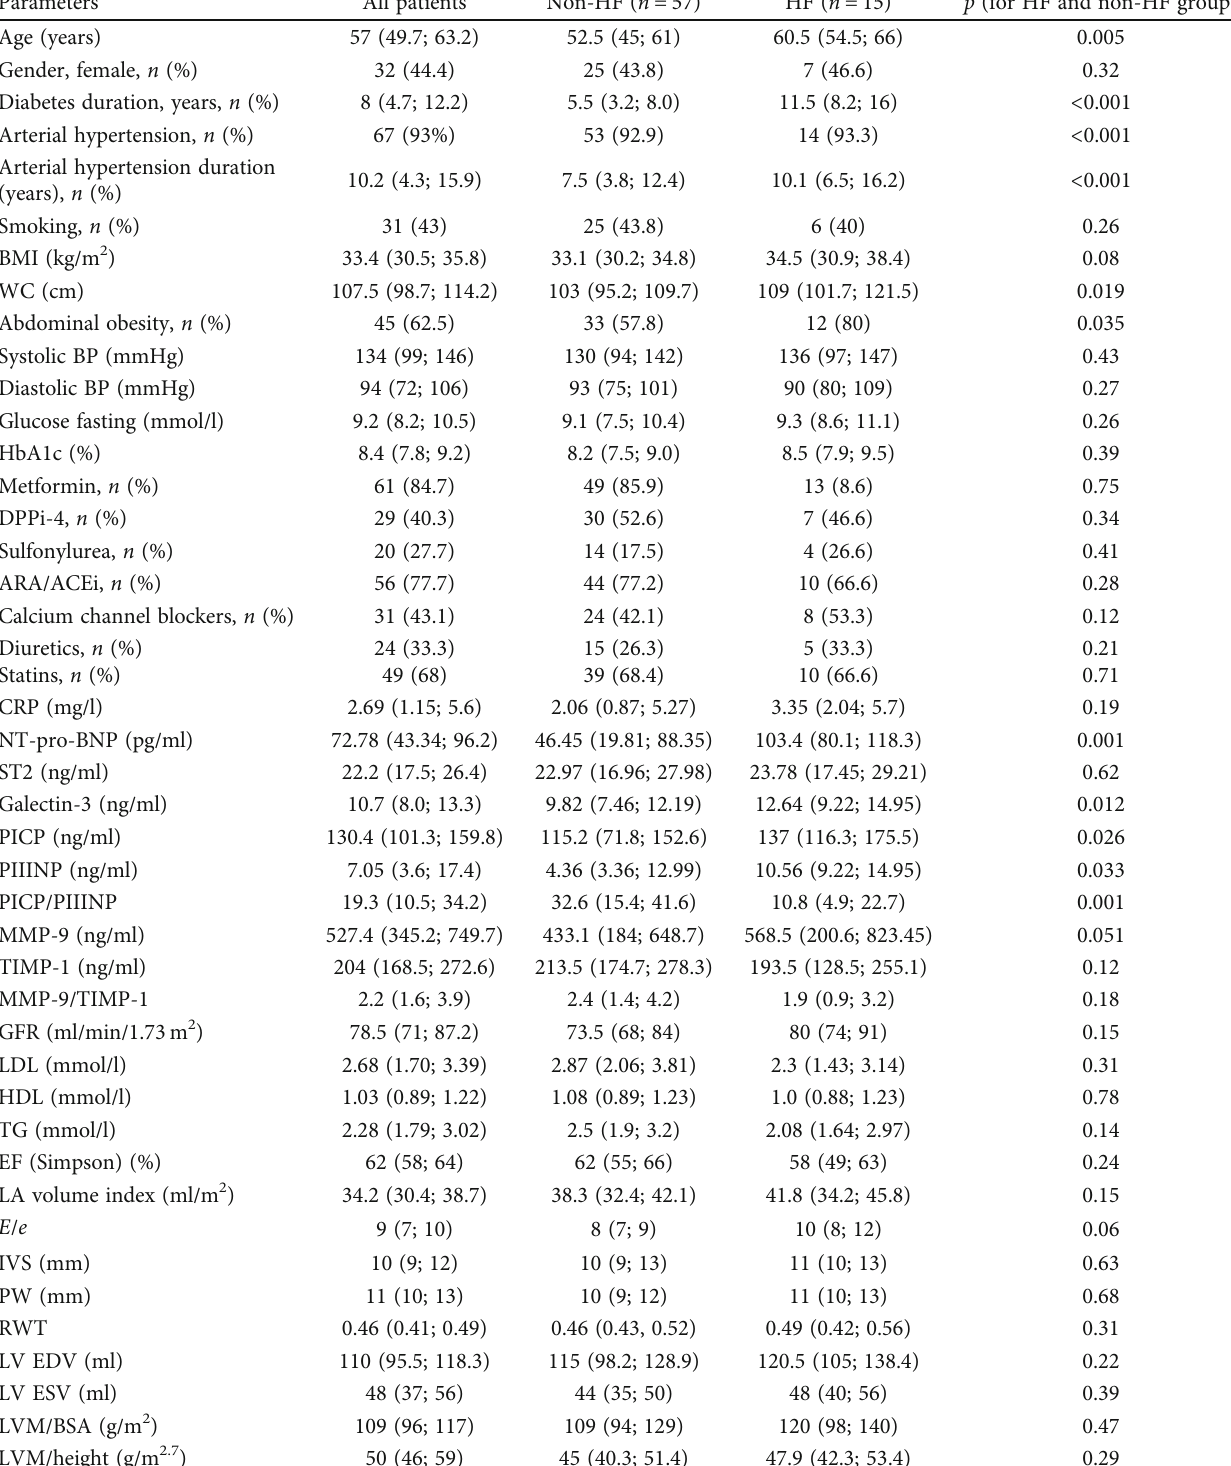
Table 1: Baseline clinical characteristics and echocardiographic and biomarker data of study population, Me (25; 75), n (%). Parameters All